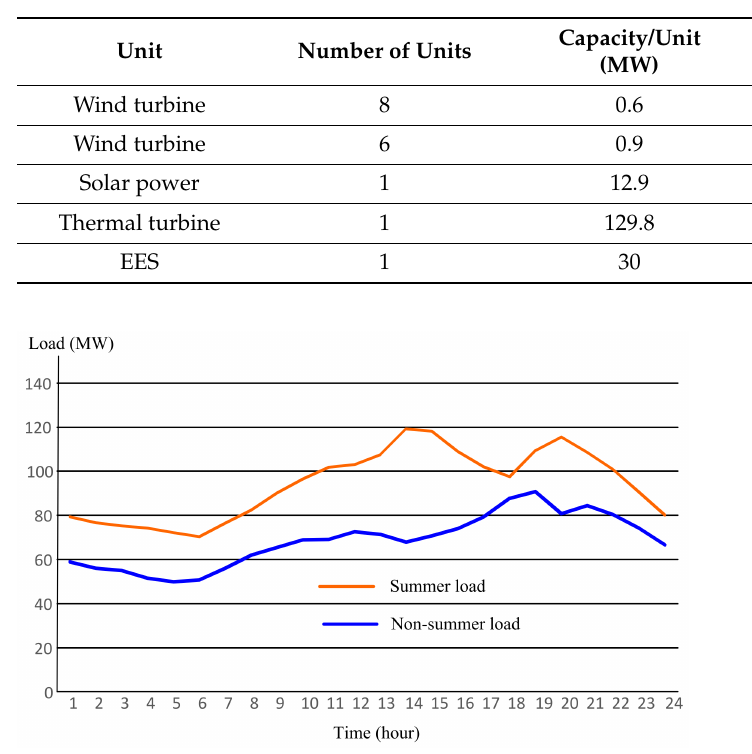
Figure 5. The modified Penghu grid. Table 1. The associated data of the modified Penghu grid system.